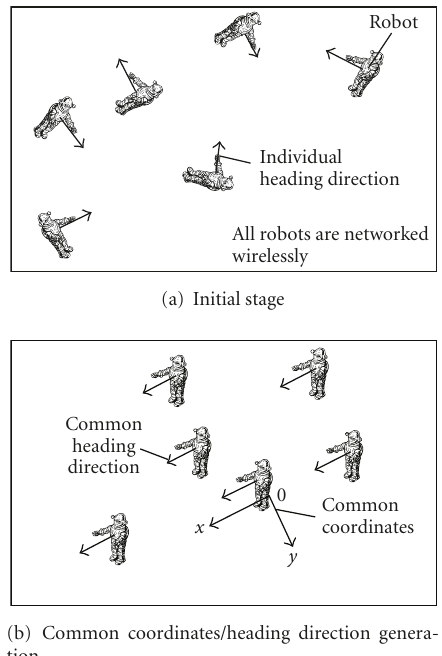
Figure 1: Problem of common coordinates/heading